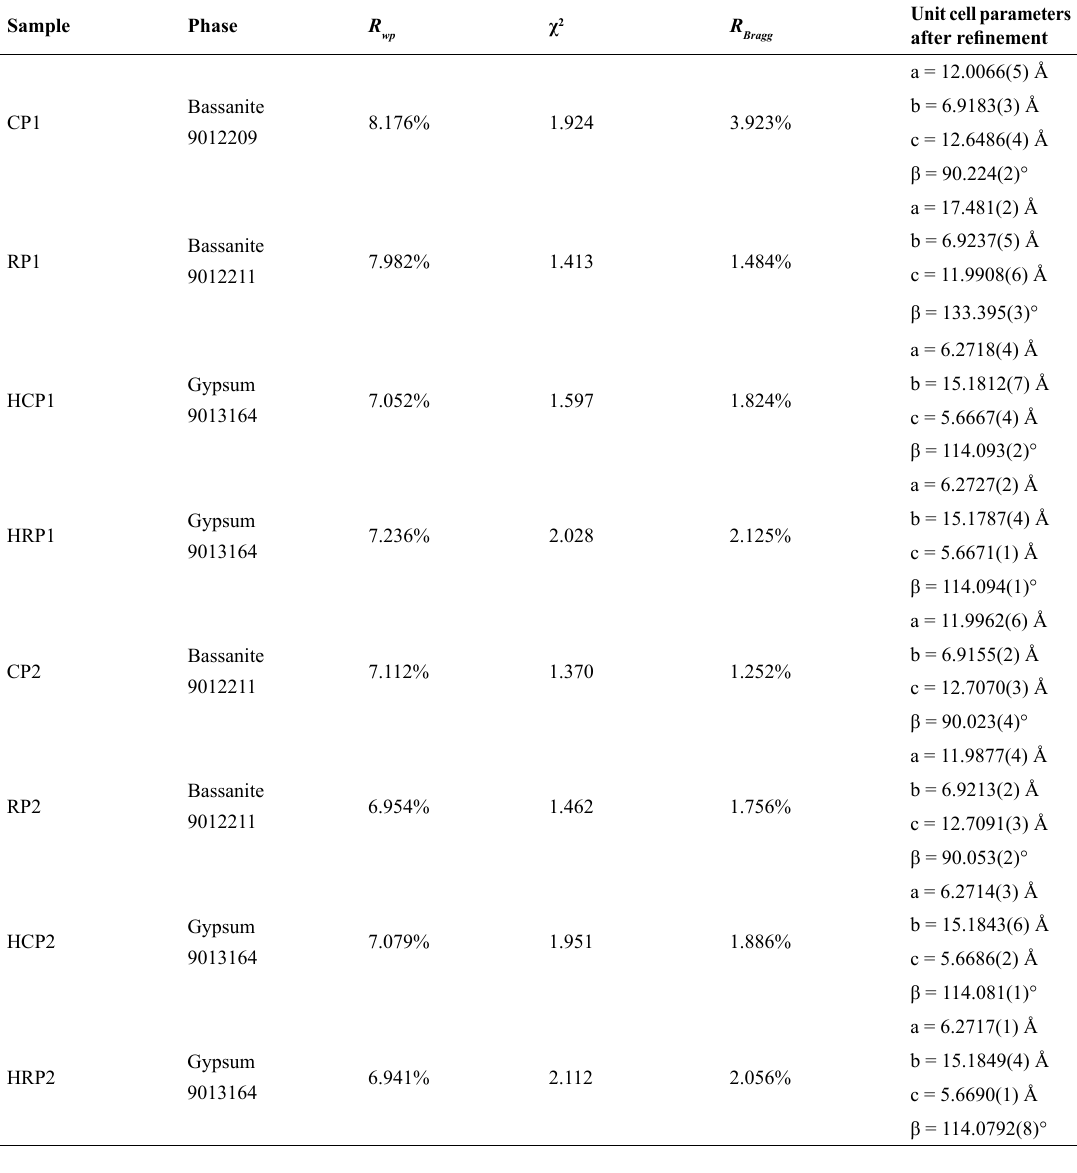
, χ 2 , R , and unit cell parameters of main phases after refinement. Table 3. R wp Bragg Sample